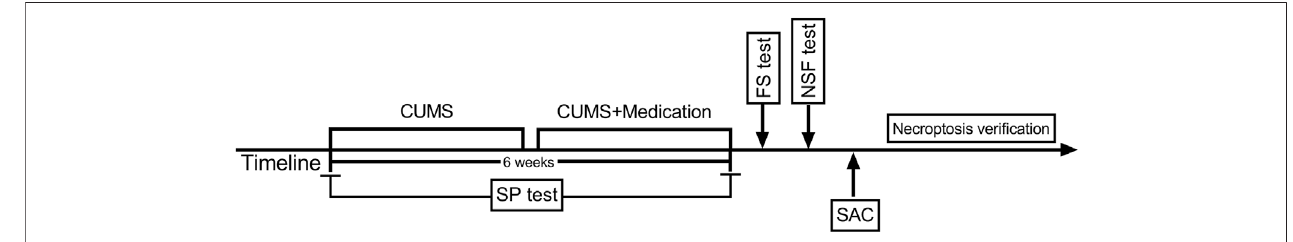
FIGURE 2 | Schedule of the experimental